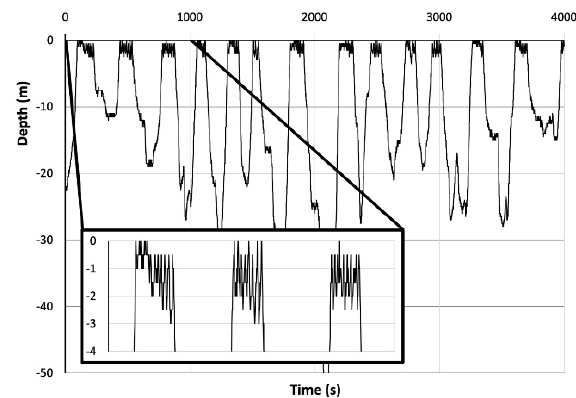
Figure 9: Example of a dive series from #3965 showing the typical +100 s surface duration and +300 s dive durations. The first surface events show depth readings just below 2 m that by definition of a dive (>3 m depth) is included in the duration of the surfacing event (Method 1). The insert show that the 2 m threshold is crossed multiple times leading to unreasonable short dive and surface durations when using the 2 m as a strict